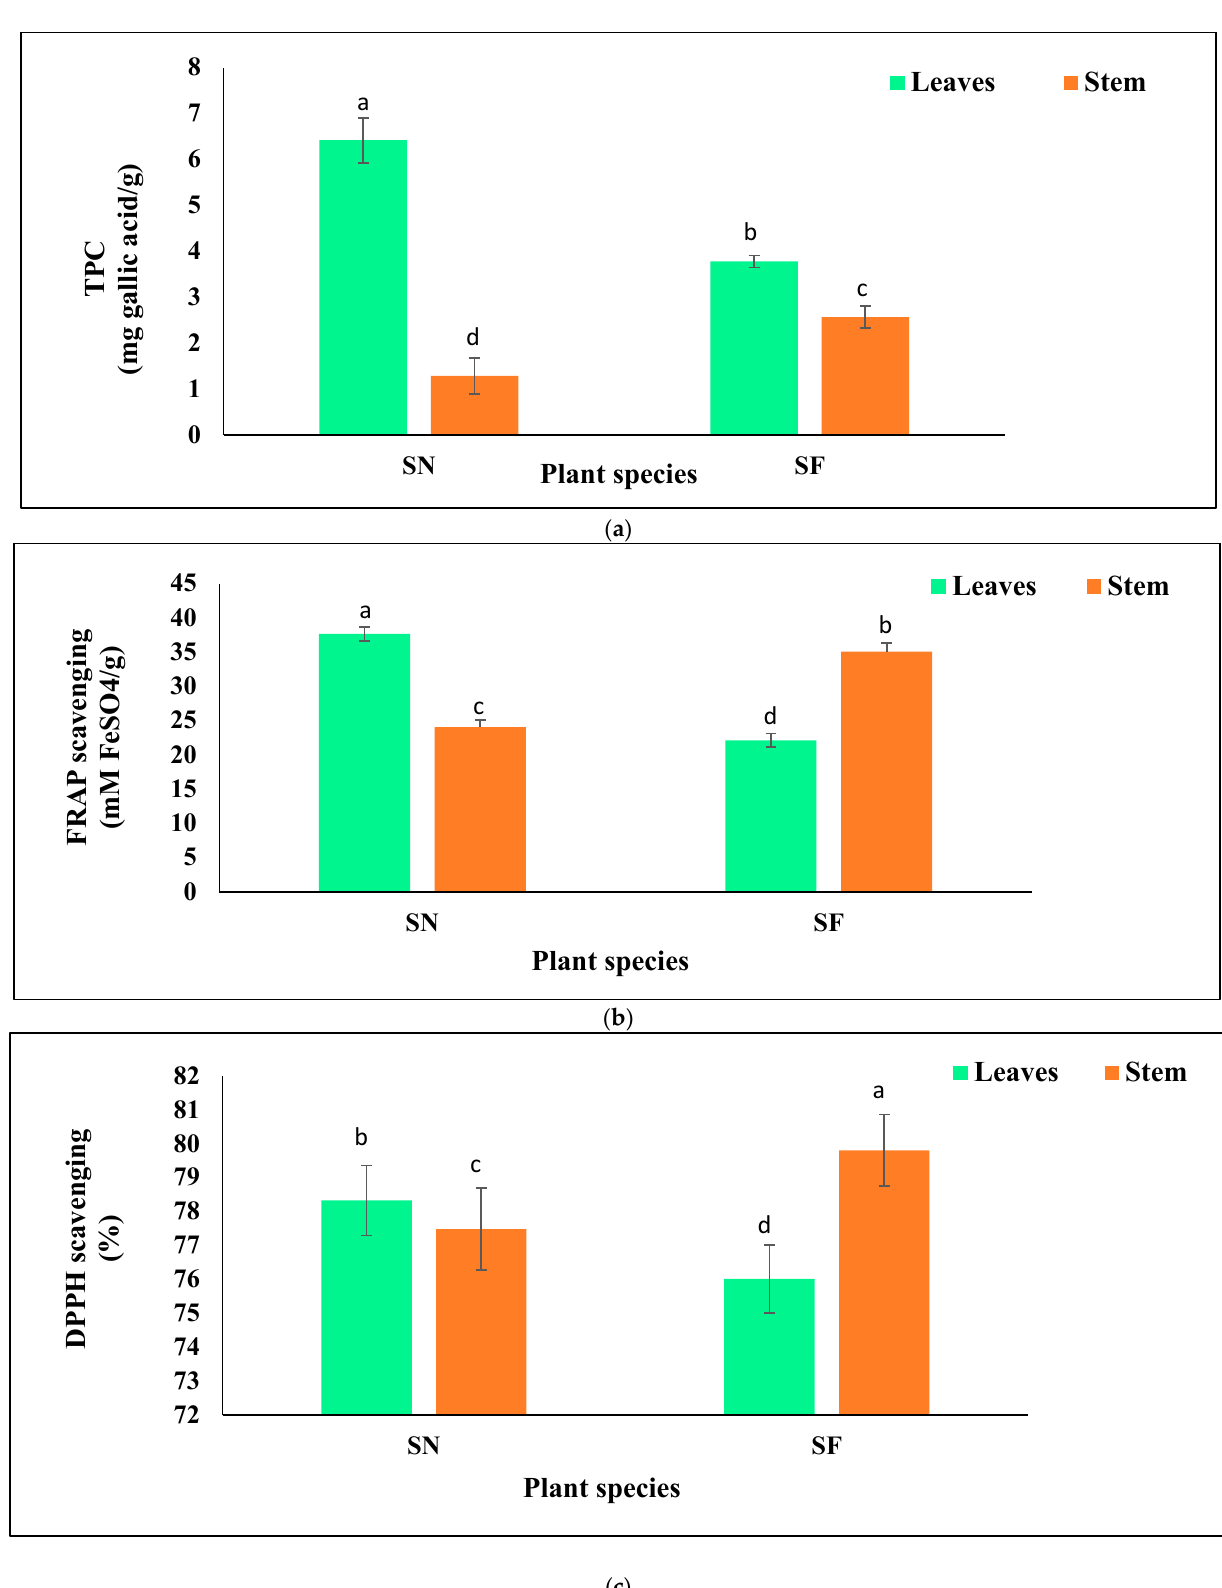
Figure 3. TPC and antioxidant (FRAP and DPPH) activity in leaves and stem parts of the plants (DMRT), ( a ) = TPC, ( b ) = FRAP, ( c )= DPPH, SN = S. nudiflora, SF = S. fruticosa. Note: Statistically significant differences ( p ≤ 0.05) between plant parts are marked with superscripts a, b, c, and d.